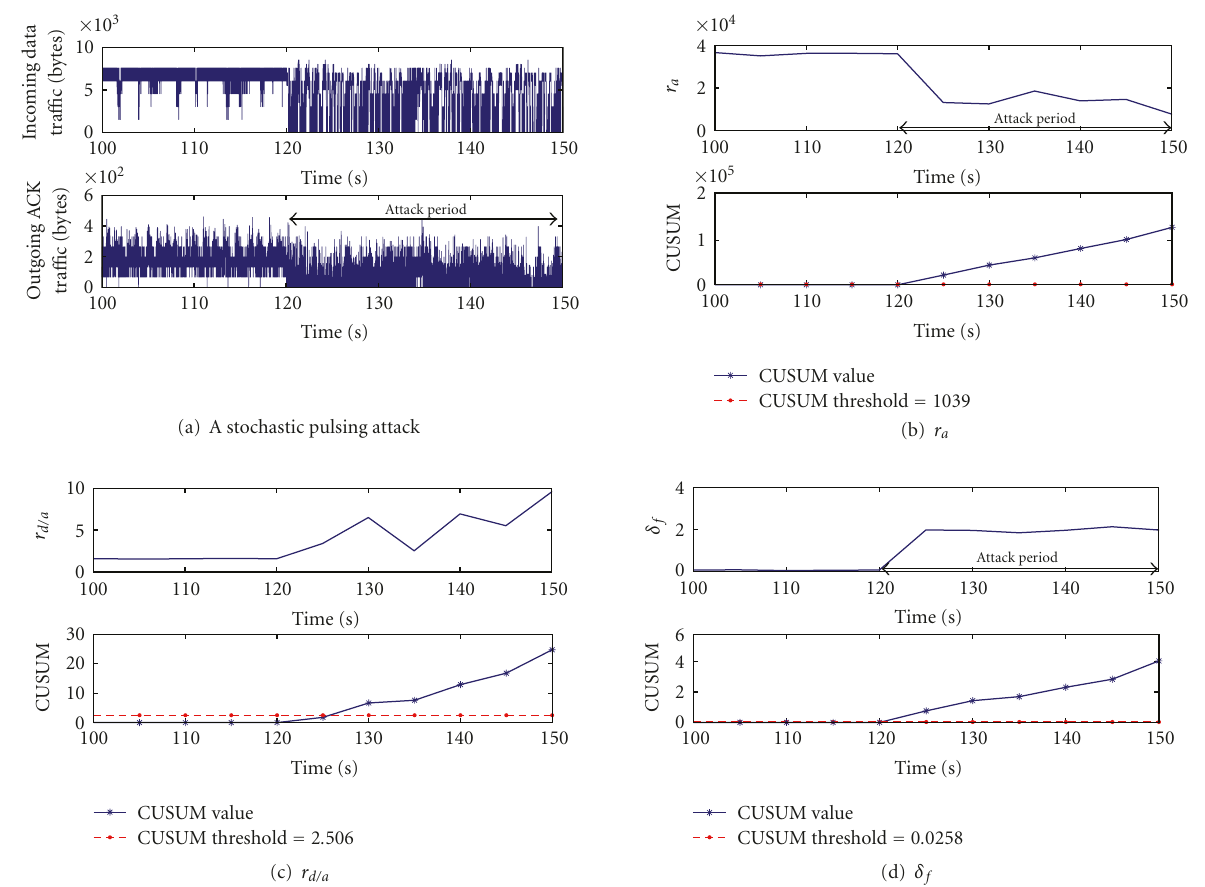
Figure 5: Detecting stochastic pulsing attacks using